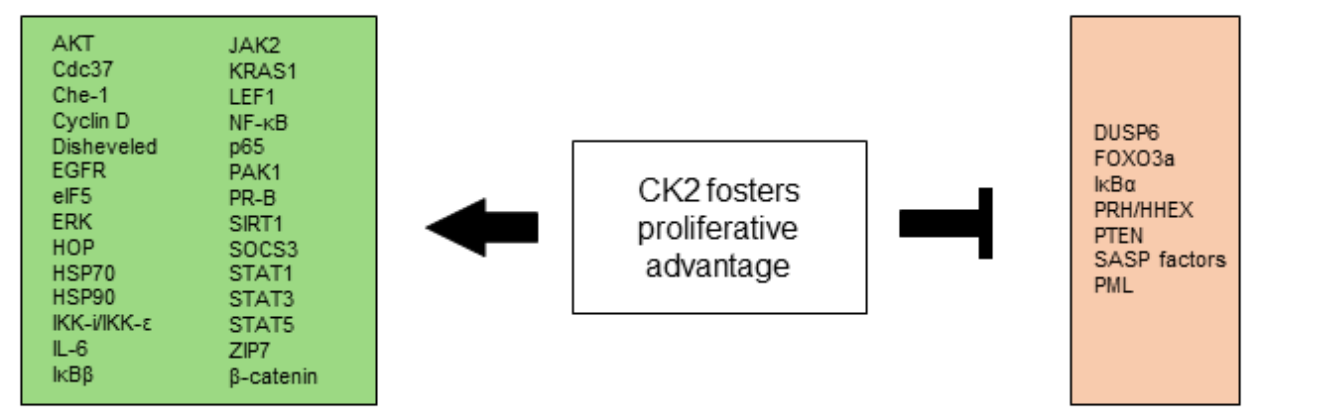
Figure 1. CK2-dependent modified proteins involved in proliferative advantage. Proteins that are activated in this process by CK2 modification are shown on the left (highlighted in green), and proteins that are restricted in their function are shown on the right (highlighted in red).